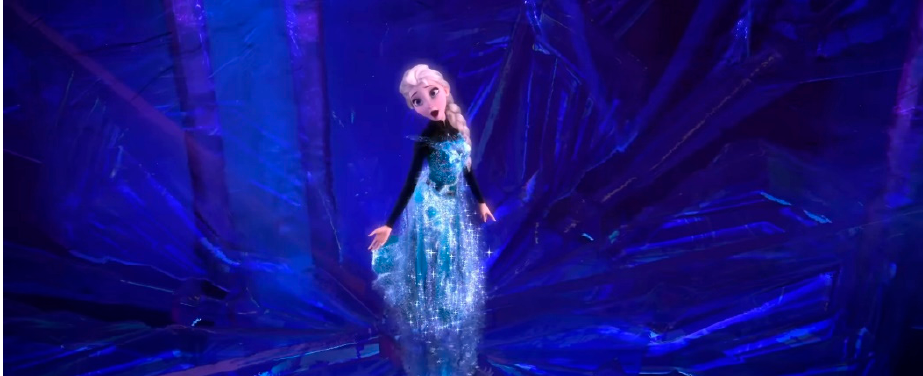
Figure 4. Elsa creating her dress (Walt Disney Animation Studios 2013a).